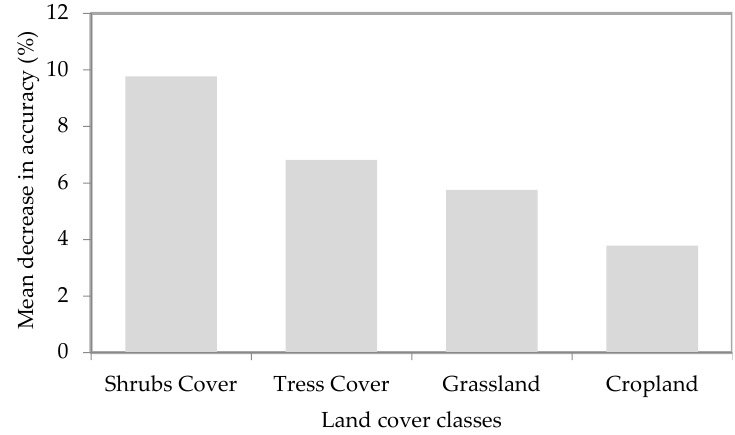
Figure 7. The relevance of the four major land use/land cover classes to the habitat suitability of African citrus triozid ( Trioza erytreae ) using a random forest variable importance rank.